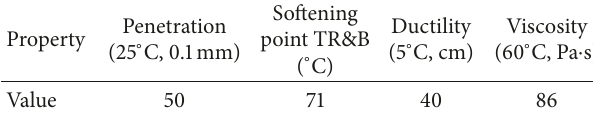
Table 2: Properties of SBS modified asphalt.